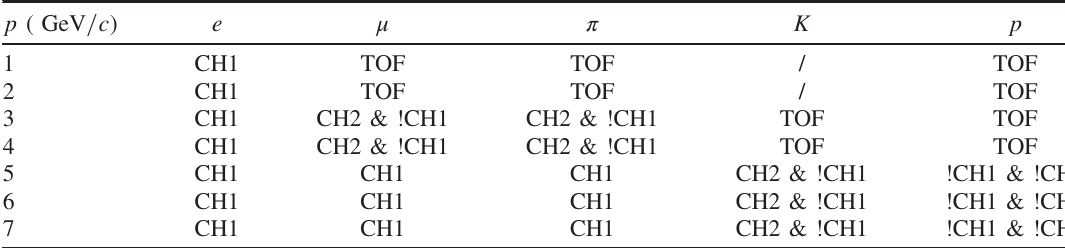
TABLE I. A summary of the particle identification techniques used in H4-VLE, in order to assess the beam composition in all